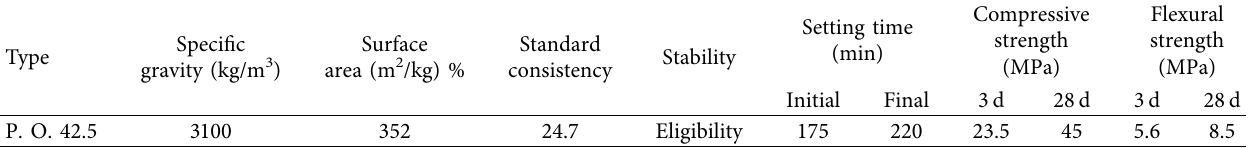
Table 1: Physical and mechanical properties of cement.